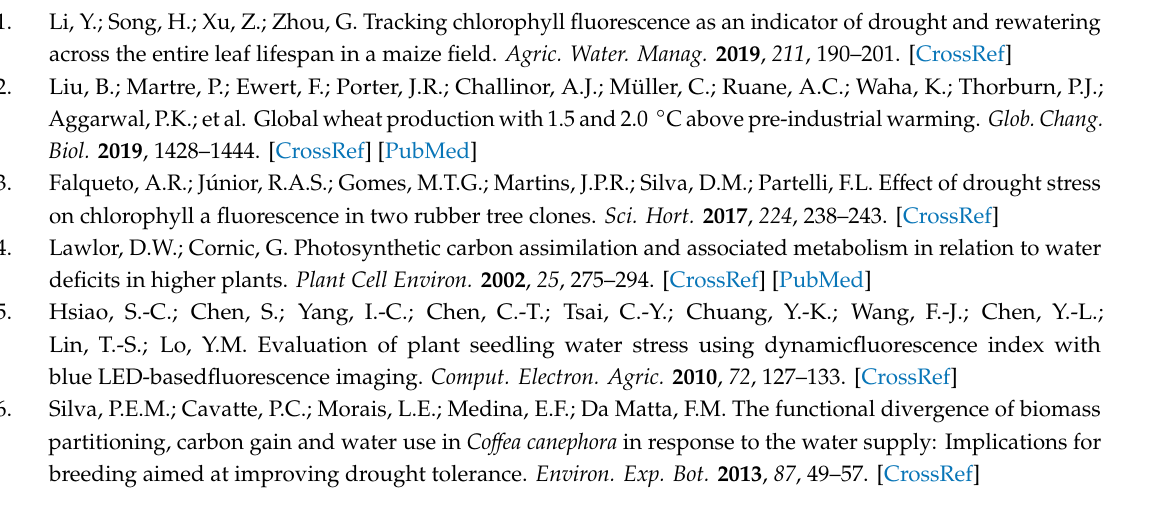
Table S1: Passport of the genetic materials used in this study, Table S2: The first two principal components for the 196 accessions of four Triticum and Aegilops species processing the D genome under water deficit stress